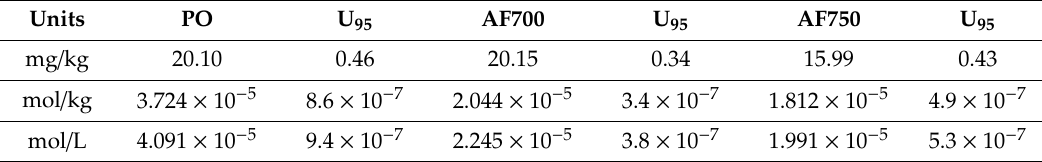
Table 1. Concentration and Uncertainty ( U 95 ) of NIST Reference Solutions for Pacific Orange